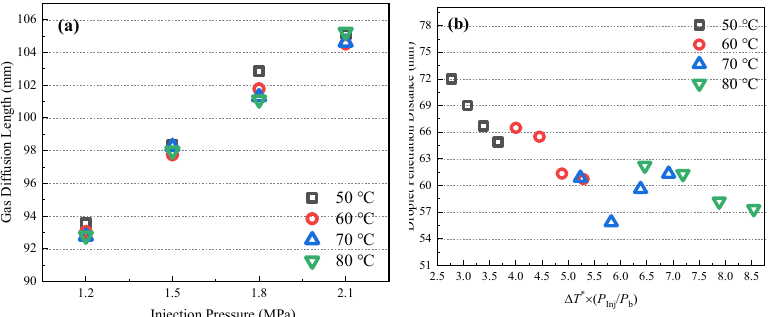
Figure 6. Variation of penetration distance with initial injection pressure and temperature. ( a ) gas diffusion length; ( b ) droplet penetration distance.